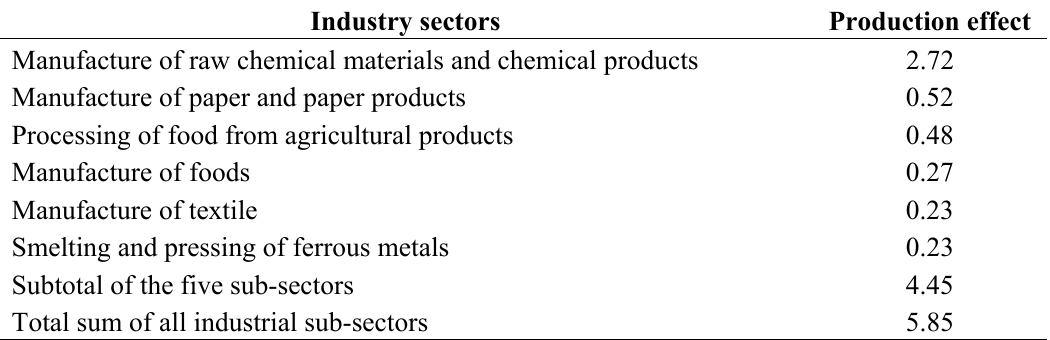
Table 6. The top six contributing sub-sectors related to the average production effect of -N discharges (10 4 industrial NH 4